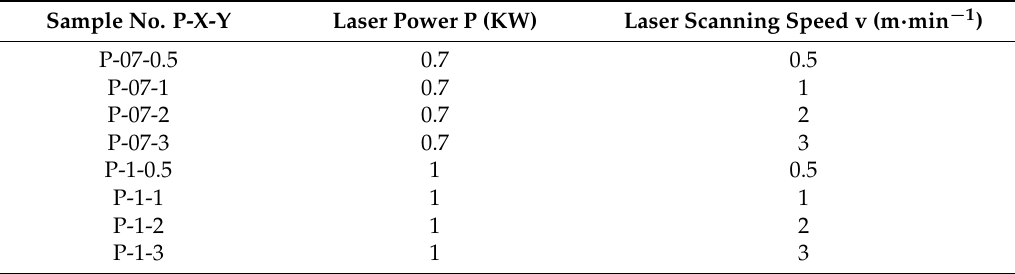
Table 1. The laser surface treatment